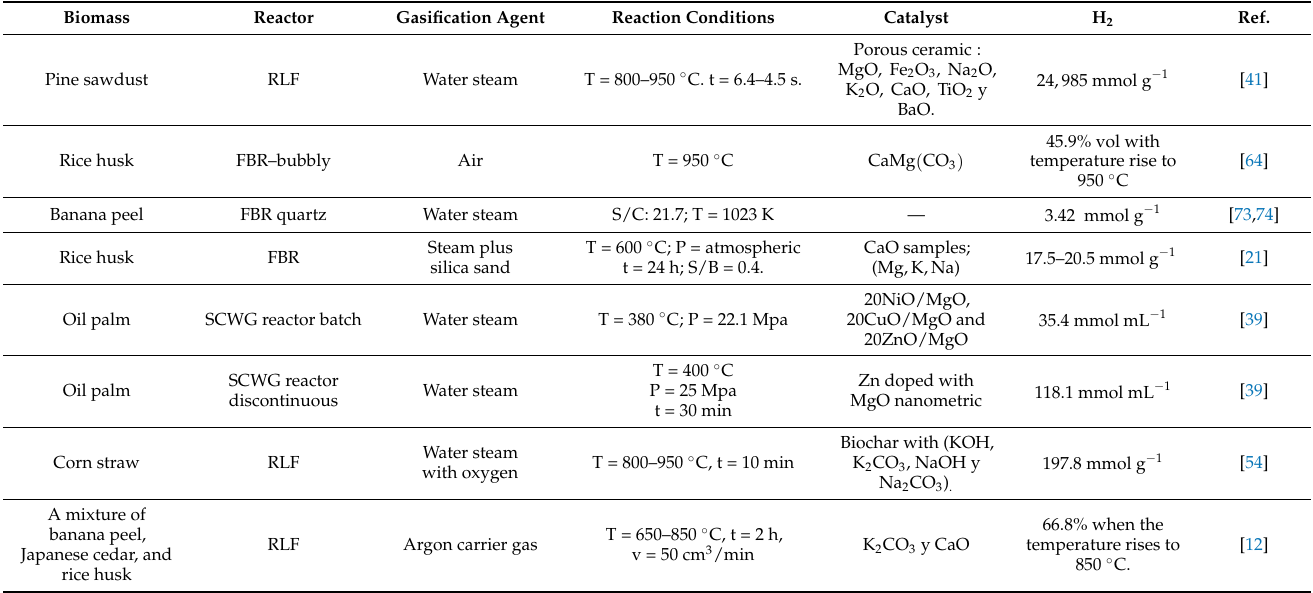
Figure 2. Gasification system scheme. Table 2. Operating conditions and results obtained using the gasification